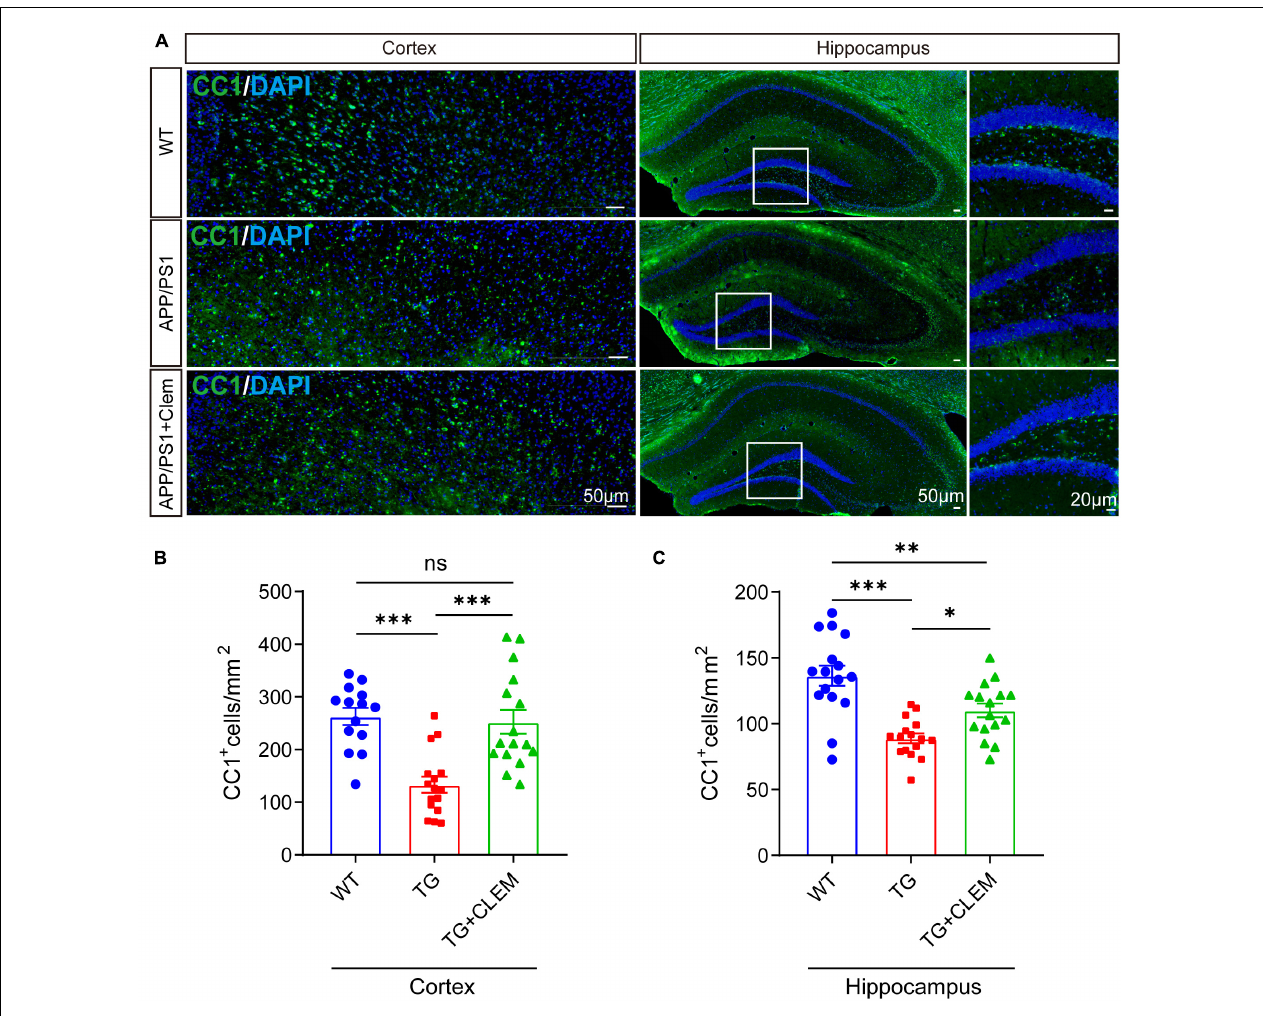
FIGURE 4 | Chronic treatment of clemastine increases number of OLs in aged APP/PS1 mice brain. (A) Confocal images of immunolabeling of CC1 (green) and 4,6-diamidino-2-phenylindole (blue) in hippocampus/cortex of WT; APP/PS1 and APP/PS1 mice treated with clemastine. White box indicates magnified area of hippocampus. (B,C) Quantification of number of CC1 + cells in hippocampus (B) and cortex (C) , respectively. Values shown represent mean ± SE. ∗ p < 0.05, ∗∗ p < 0.01, ∗∗∗ p < 0.001, n = 4 mice per group, one-way analysis of variance with Student’s t